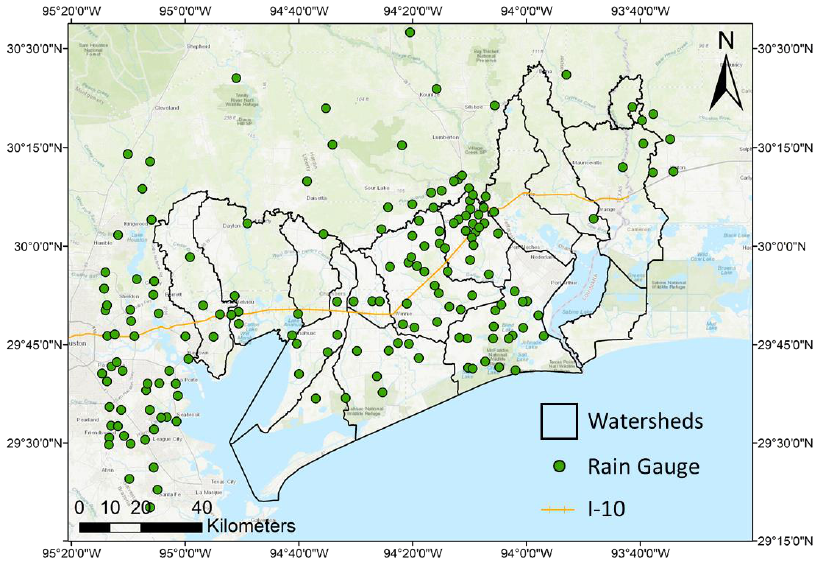
Figure 1. Study area including the watersheds and the total rain gauges assessed.